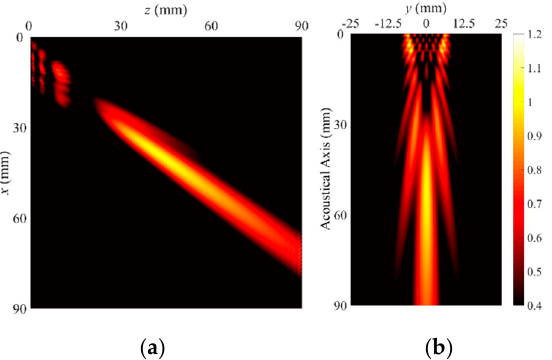
Figure 5. Radiation patterns and beam profiles of leaky A(0,0) mode Lamb wave, ( a ) vertical beam profile, and ( b ) lateral beam profile.